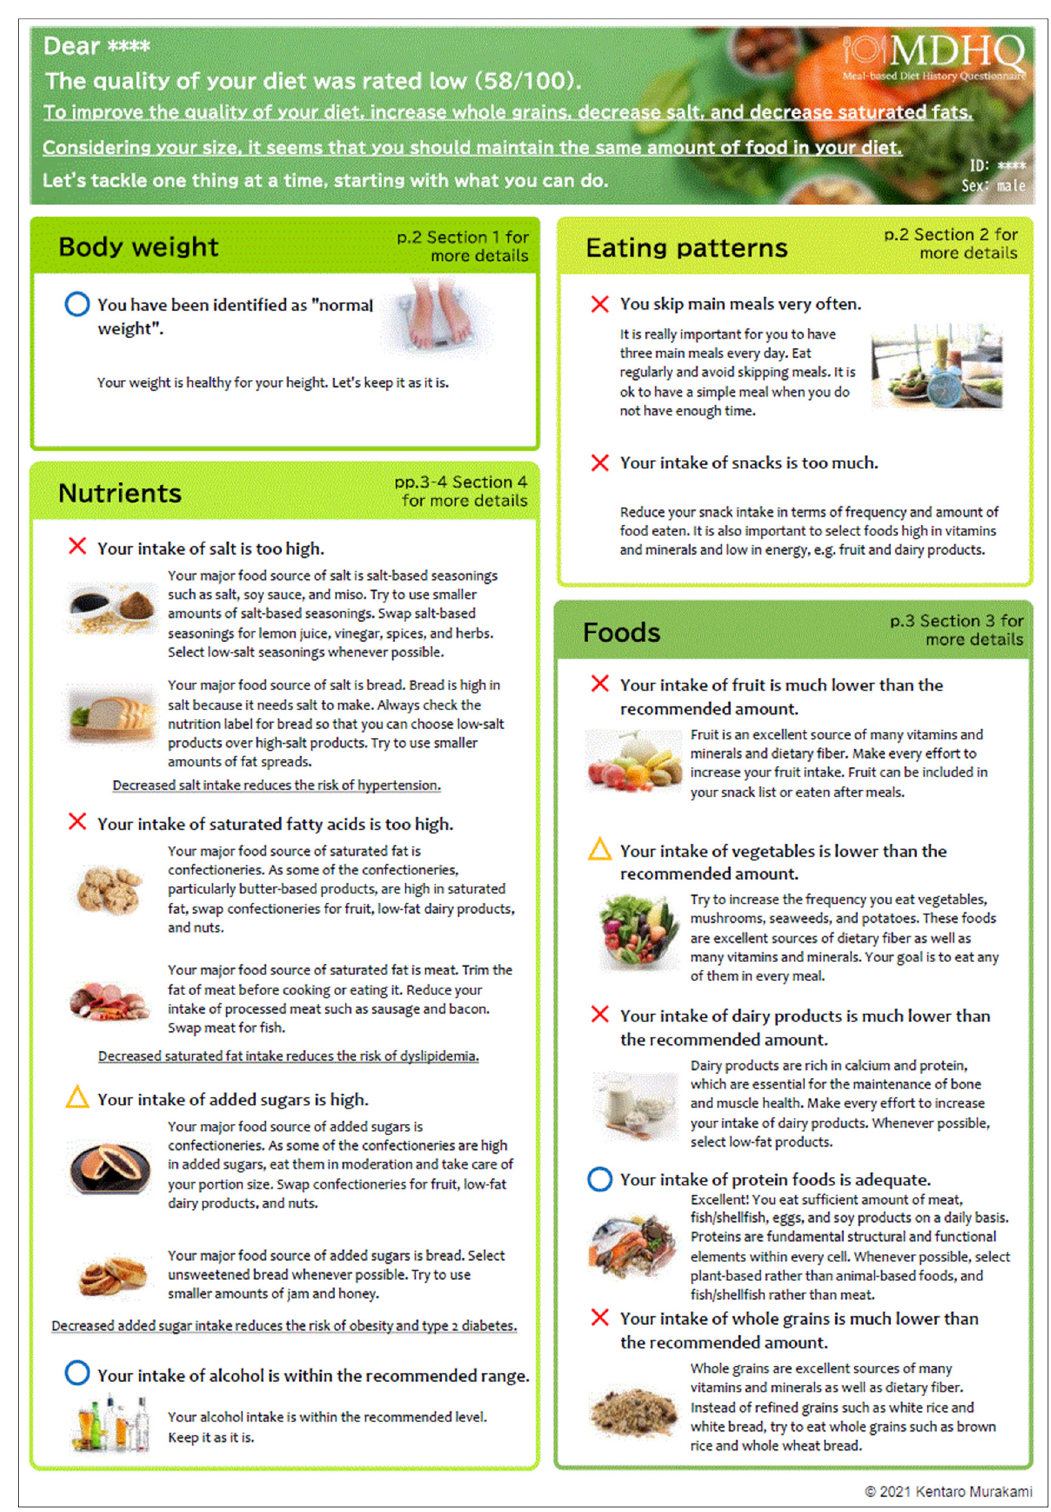
Figure 2. Part 1 (page 1) of the dietary feedback report. This is a summary of feedback accompanied by personalized messages. On the top box, an assessment of overall diet quality, as assessed by the Healthy Eating Index-2015 total score for the total diet, is shown, as well as the Big 3, i.e., three most relevant components for the improvement of overall diet quality, and a piece of advice on the amount of foods consumed based on weight status. Shown below the top box are qualitative assessment and personalized messages for 12 selected components, divided by categories of weight status, eating patterns, nutrient intake, and food group intake. Here, the translated version is shown; the original is in Japanese.